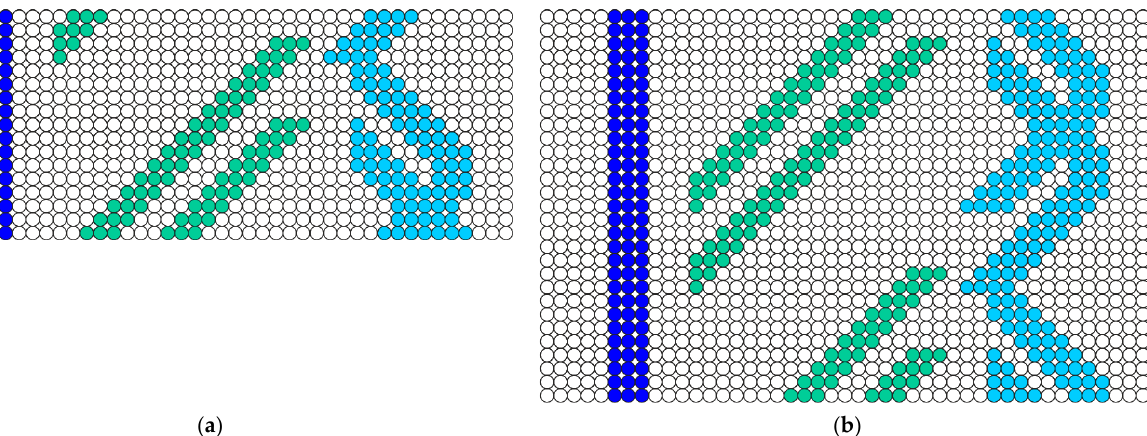
Figure 5. Illustrating the influence of a wrongly determined number lines of image on the result of coherent summation (a summation of two first images): ( a ) for a small number lines of image, ( b ) for a large number lines of image.